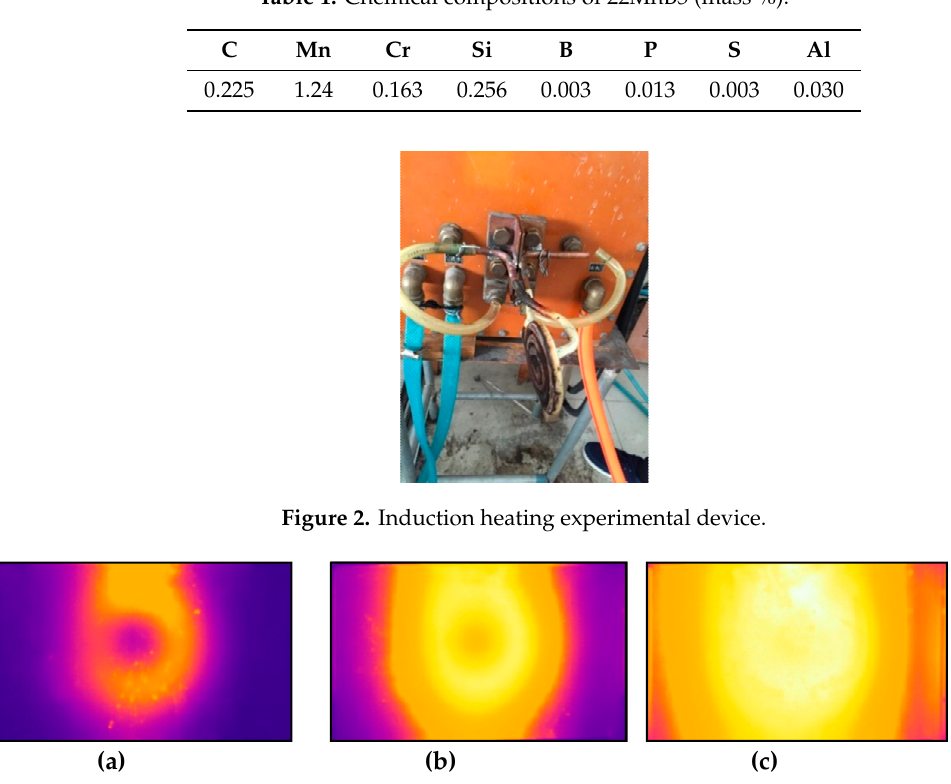
Figure 3. Temperature variation of induction heating workpiece: ( a ) in the beginning; ( b ) in the middle; ( c ) at the end.